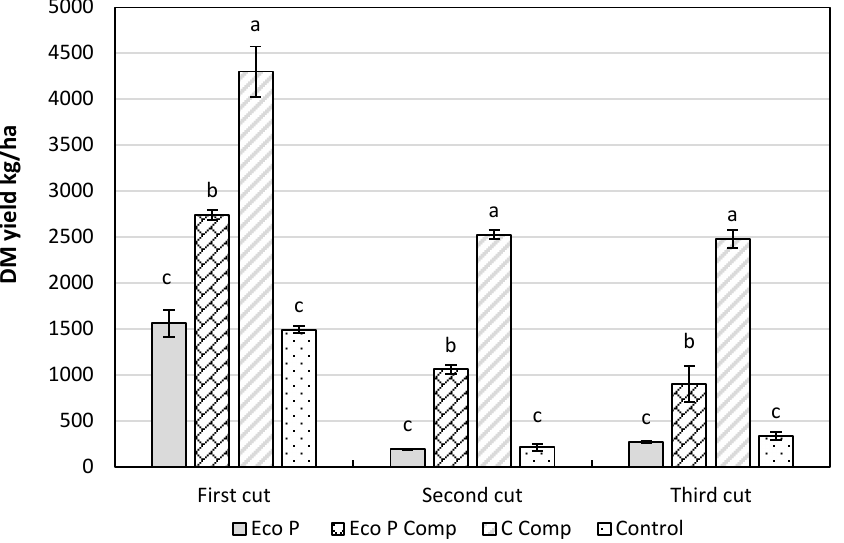
Figure 6. Effect of fertiliser treatment on grass DM yield over the third year (2020) grass harvest; within each harvest, shared letters denote that no statistically significant difference occurred ( p > 0.05); error bars indicate standard error.